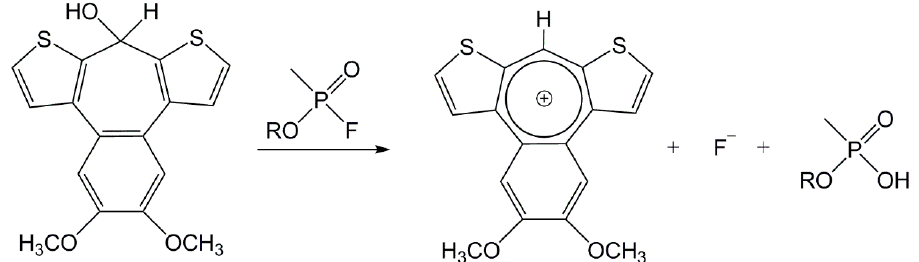
Figure 2. The dithienobenzotropone monomer (RM1a) reaction scheme with the G type nerve agents (modified according to Reference [9]).